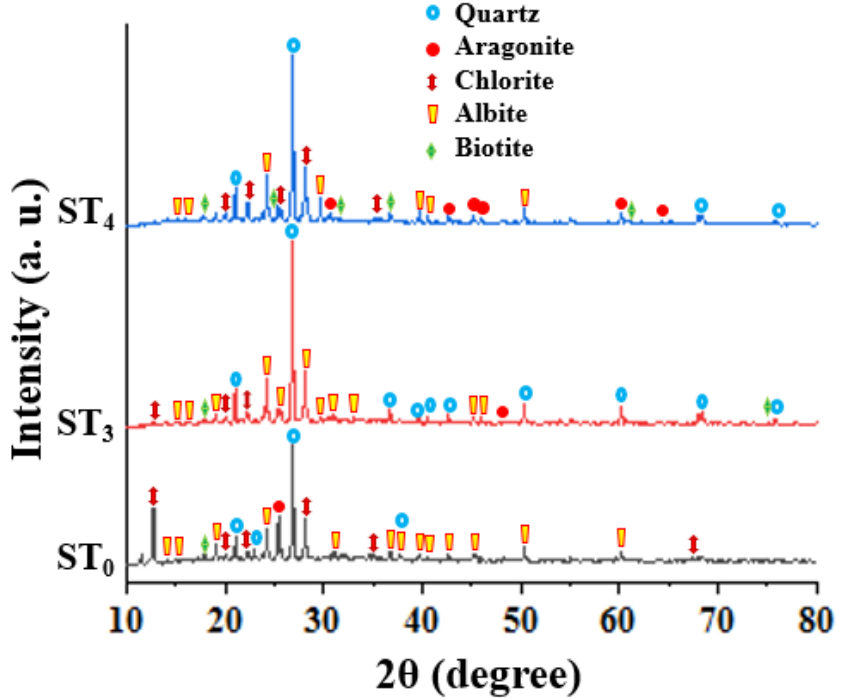
Figure 8. Mineral phases in the studied samples using XRD method (ST 0 – sample at 22 °C; ST 3 – sample heated to 600 °C; ST 3 – sample heated to 800 °C).